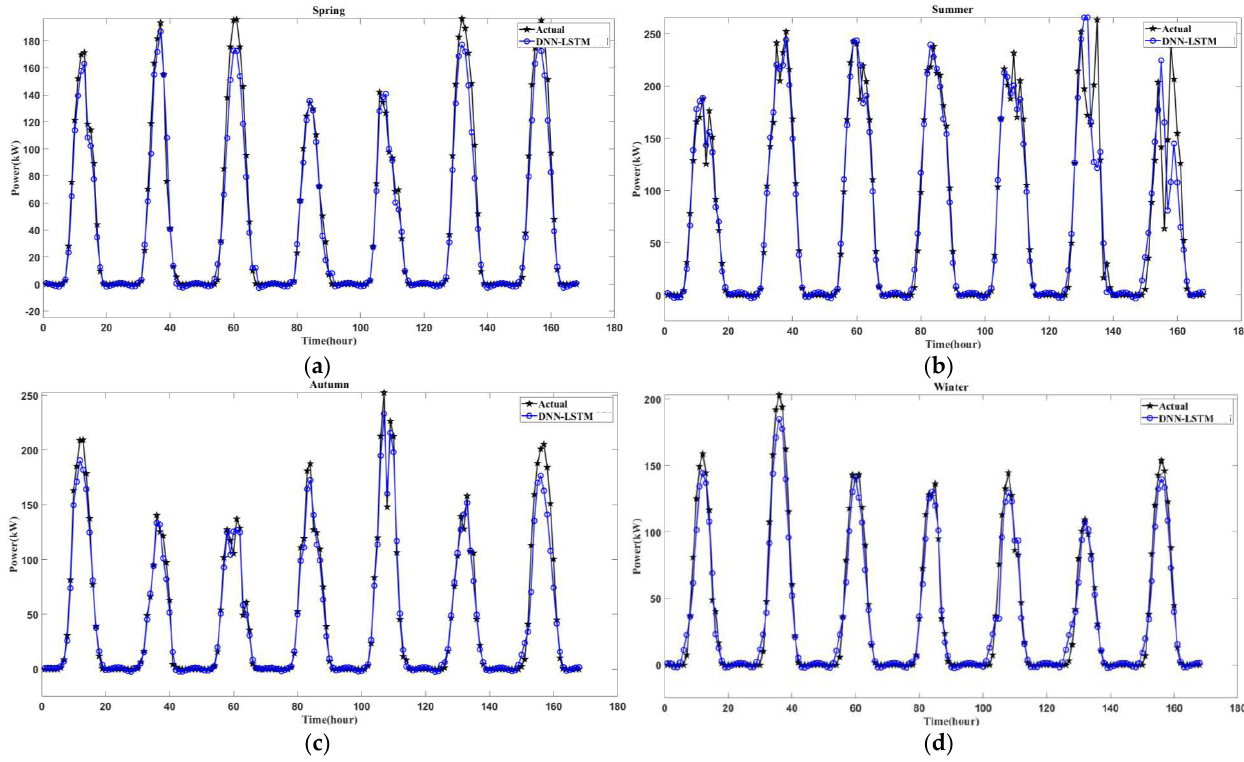
Figure 11. Hourly power generation forecasting results by DNN- LSTM during one week for solar power plant F: ( a ) spring; ( b ) summer; ( c ) autumn; ( d ) winter. Table 10. Comparisons of performance indicators of five forecasting models for solar power plant F.